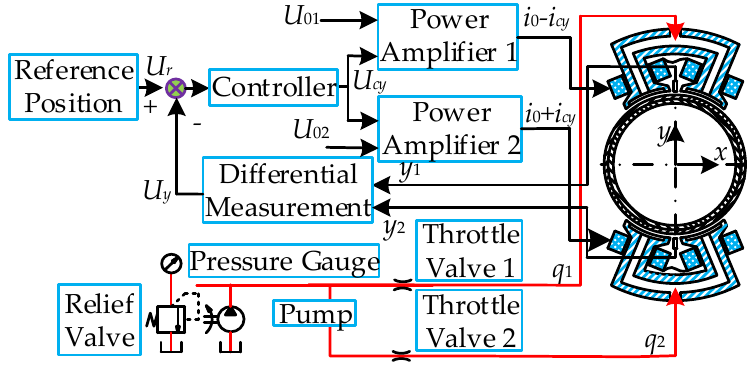
Figure 5. Single Supporting System of MLDSB.